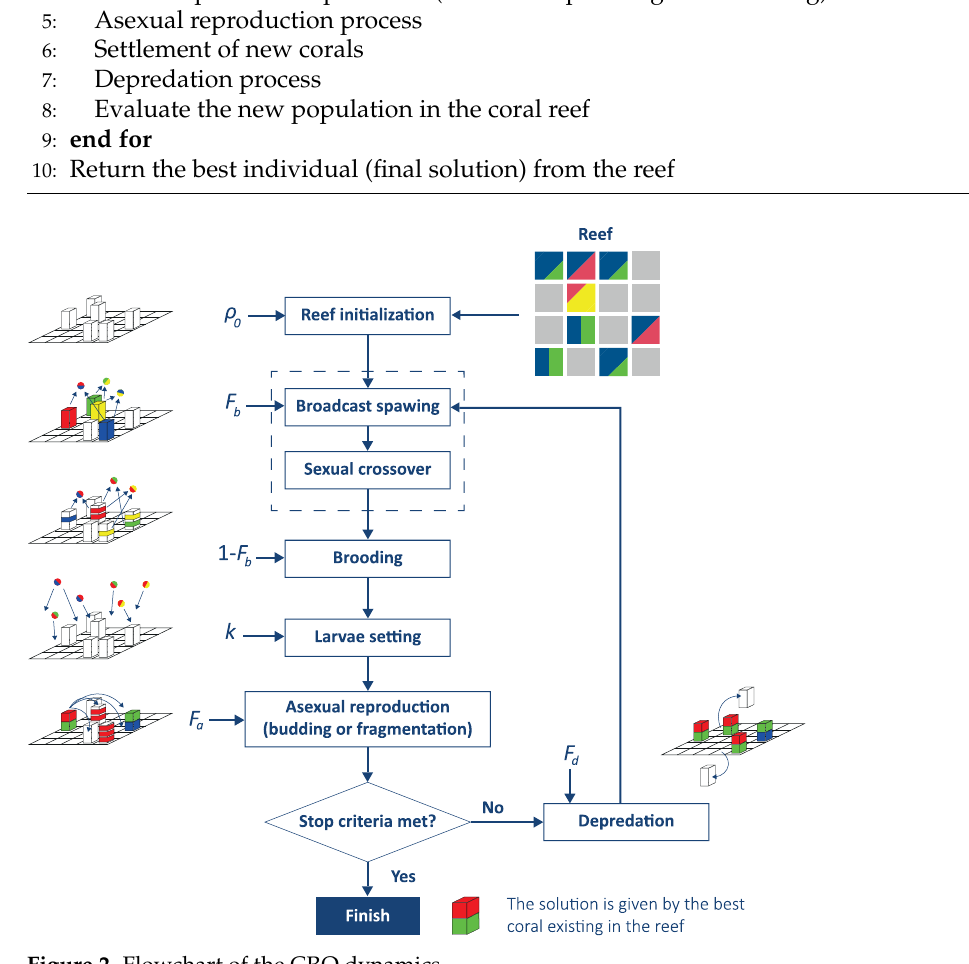
Figure 2. Flowchart of the CRO